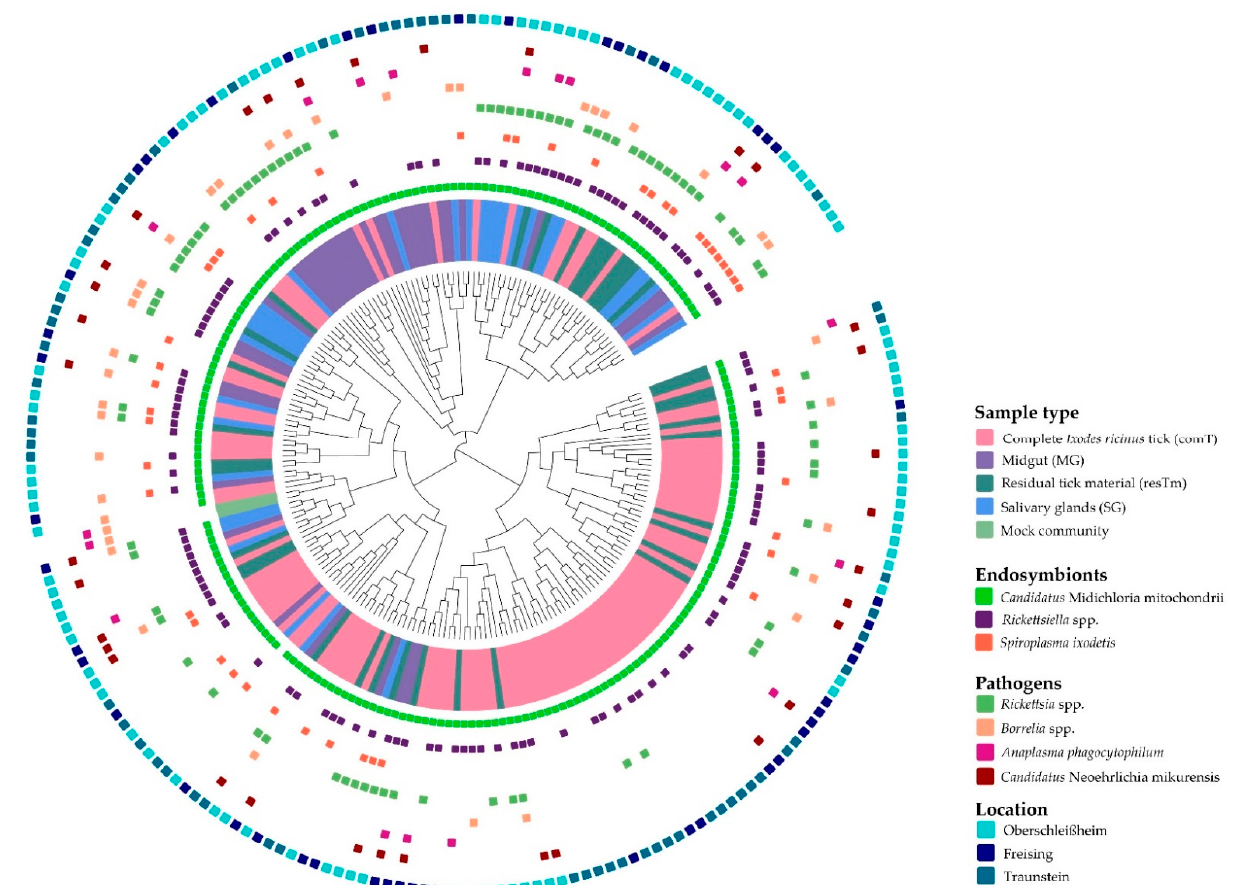
Figure 3 . β -diversity is displayed as a circular dendrogram using a phylogenetic tree in the middle to demonstrate the genetic and taxonomic closeness and relationship, as well as the distribution of samples on phylogenetic branches. The innermost circle shows the different types of tissue highlighting their distribution. The next circles display the presence of probable endosymbionts and pathogenic bacteria in the tick microbiome. The outermost circle displays the location of the samples’ collection.